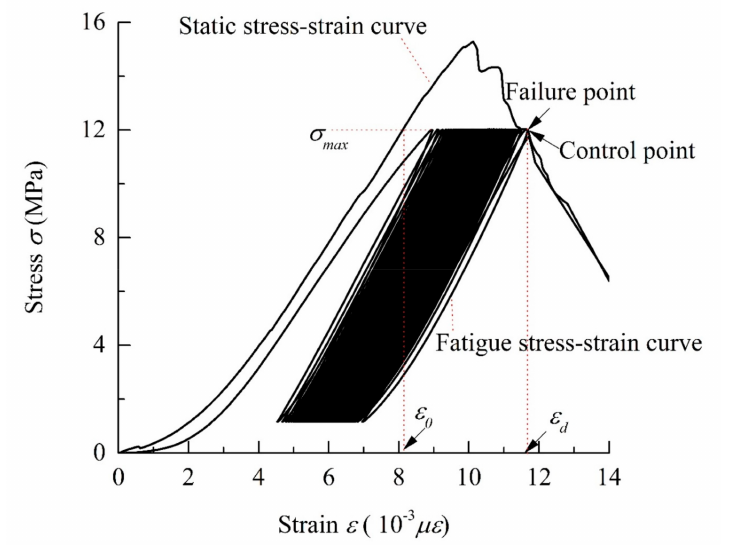
Figure 7. Static and fatigue testing